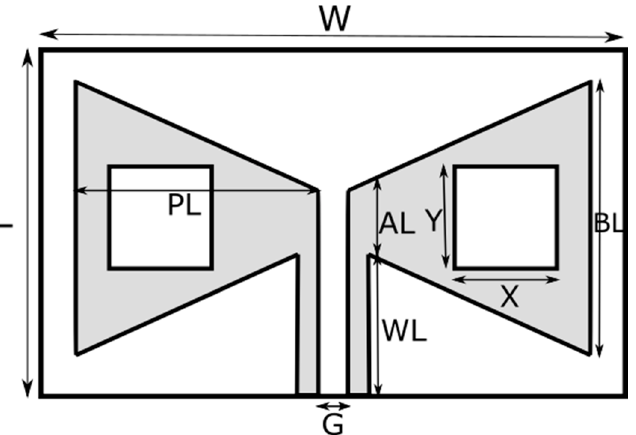
Figure 3. The design geometry of Antenna-2 and Antenna-3 with graphene substrate and different patch dimensions. Table 3. Bow-tie Antenna-2 and Antenna-3 parameters.